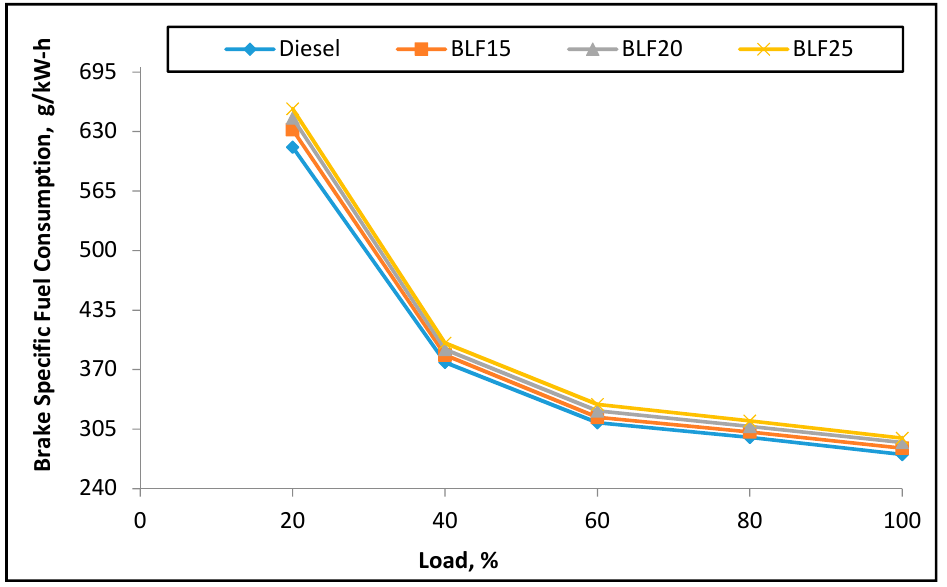
Figure 7. Variations of BSFC vs. load